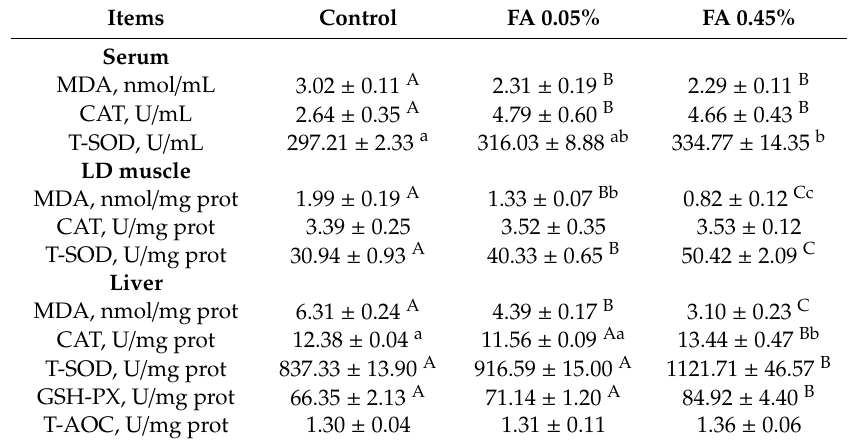
Table 1. E ff ects of dietary FA supplementation on antioxidant status in serum, LD muscle, and liver of weaned piglets.